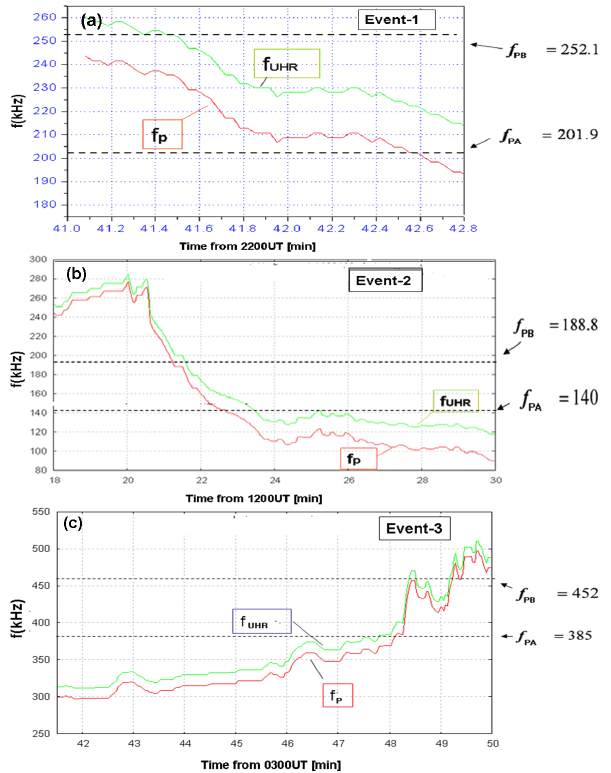
Fig. 5. Profiles of plasma and UHR frequencies vs UT for three